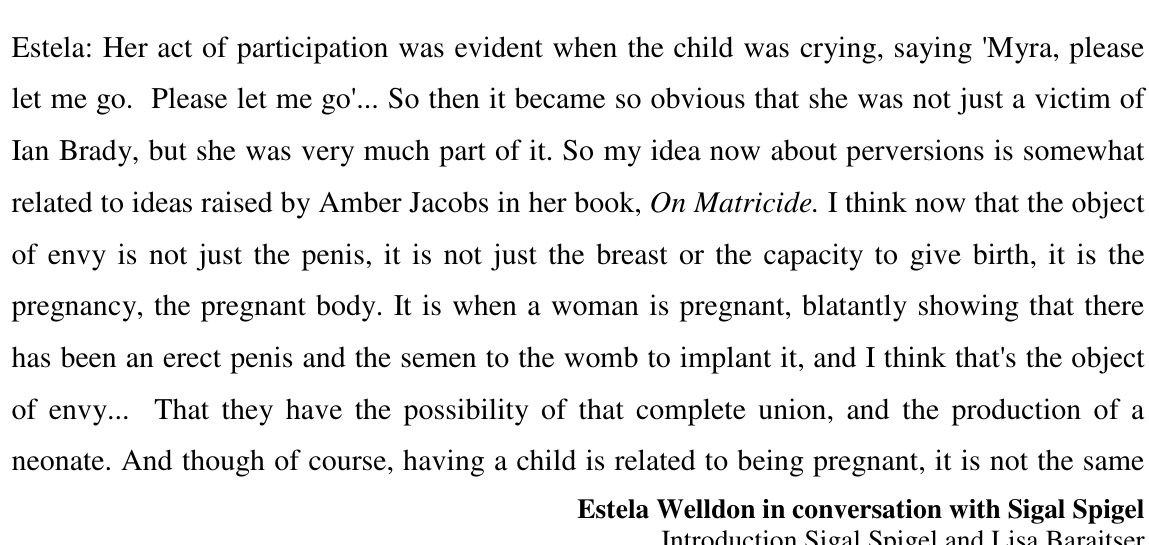
Estela Welldon in conversation with Sigal Spigel Introduction Sigal Spigel and Lisa